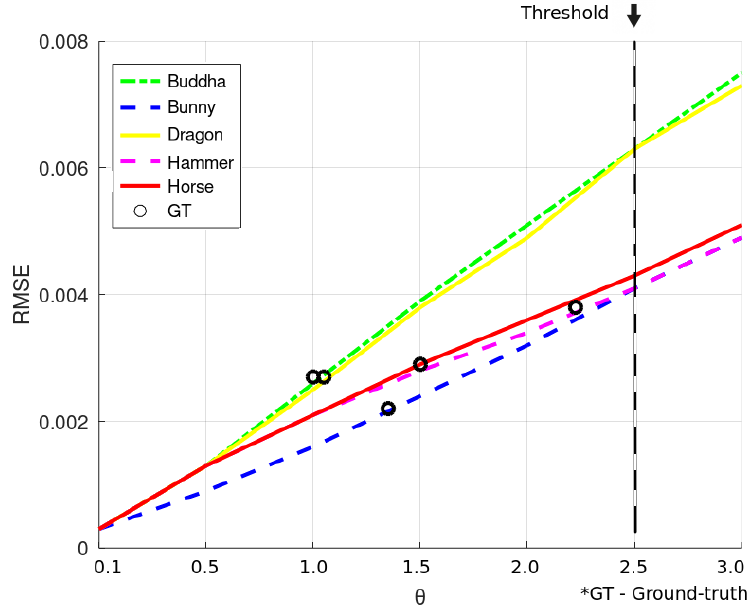
Figure 4. Measurement of the angle value (in radians) to calculate the micromisalignment